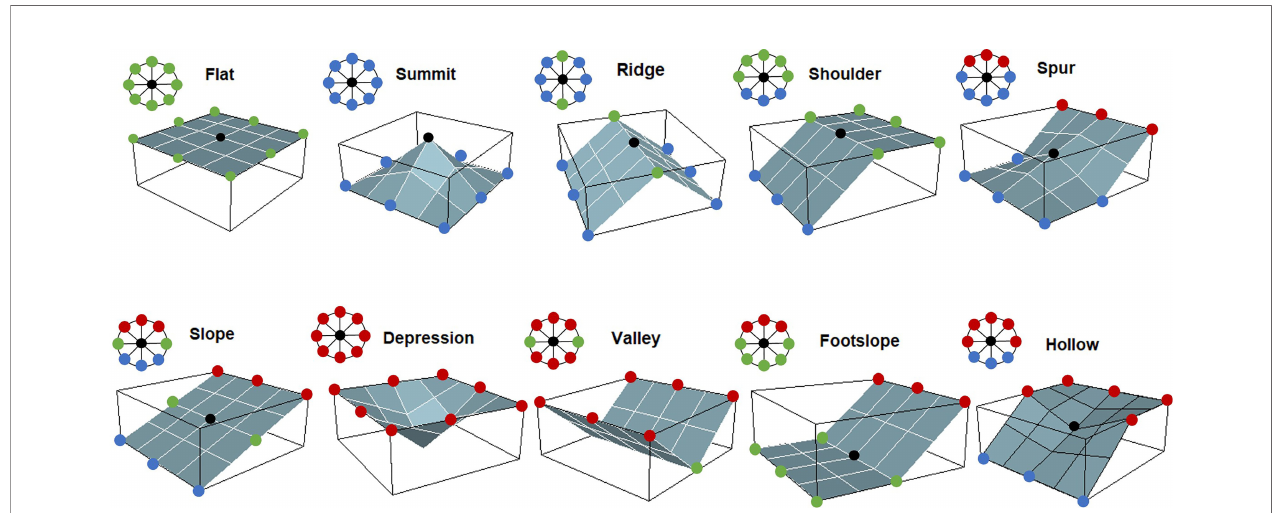
FIGURE 2 | Representative 3D morphologies and their equivalent geomorphons (ternary patterns) for the 10 most common landform elements [after Figure 3 from Jasiewicz and Stepinski (2013)]. Coloured dots indicate if the cells surrounding the central cell (black) are higher (red), lower (blue) or of the same elevation value (green) as the central